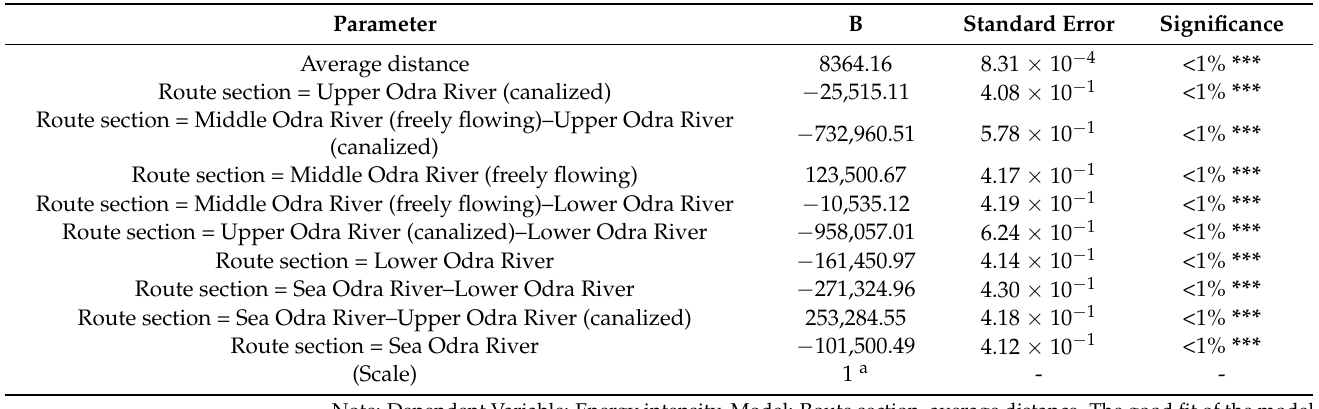
Table 8. Warning model of energy intensity in inland waterway freight transport in relation to the selection of the route section and the average distance traveled by 1 ton of